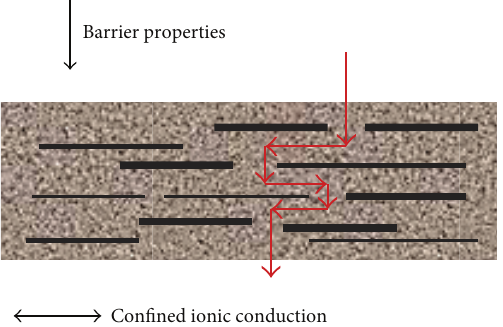
Figure 3: The barrier behavior of the nanoparticles inside polymer matrix